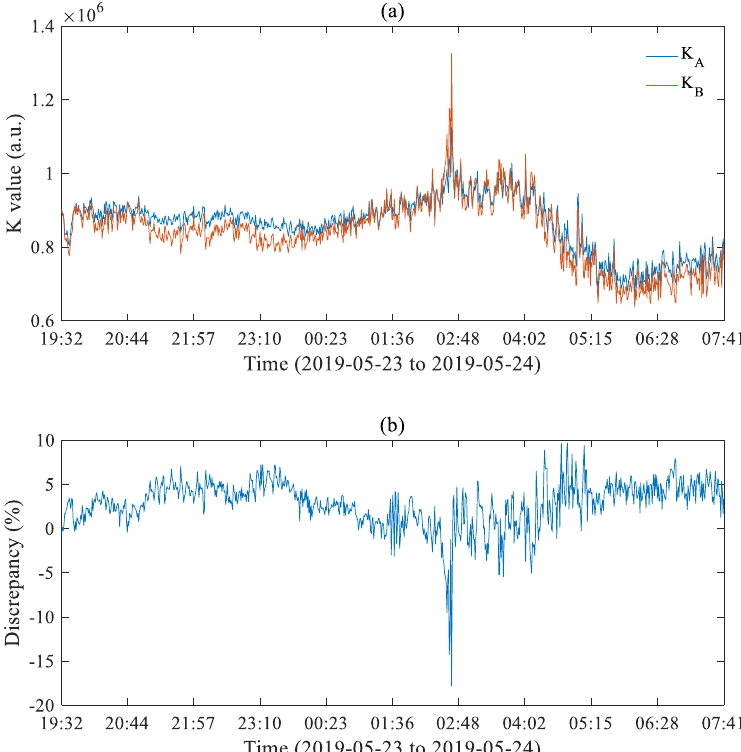
Figure 5. ( a ) Temporal distribution of the system constant calibrated in the region of 500–1500 m (region A ) and 1050–1500 m (region B ); ( b ) the discrepancy between the system constants calibrated in the regions of A and B .